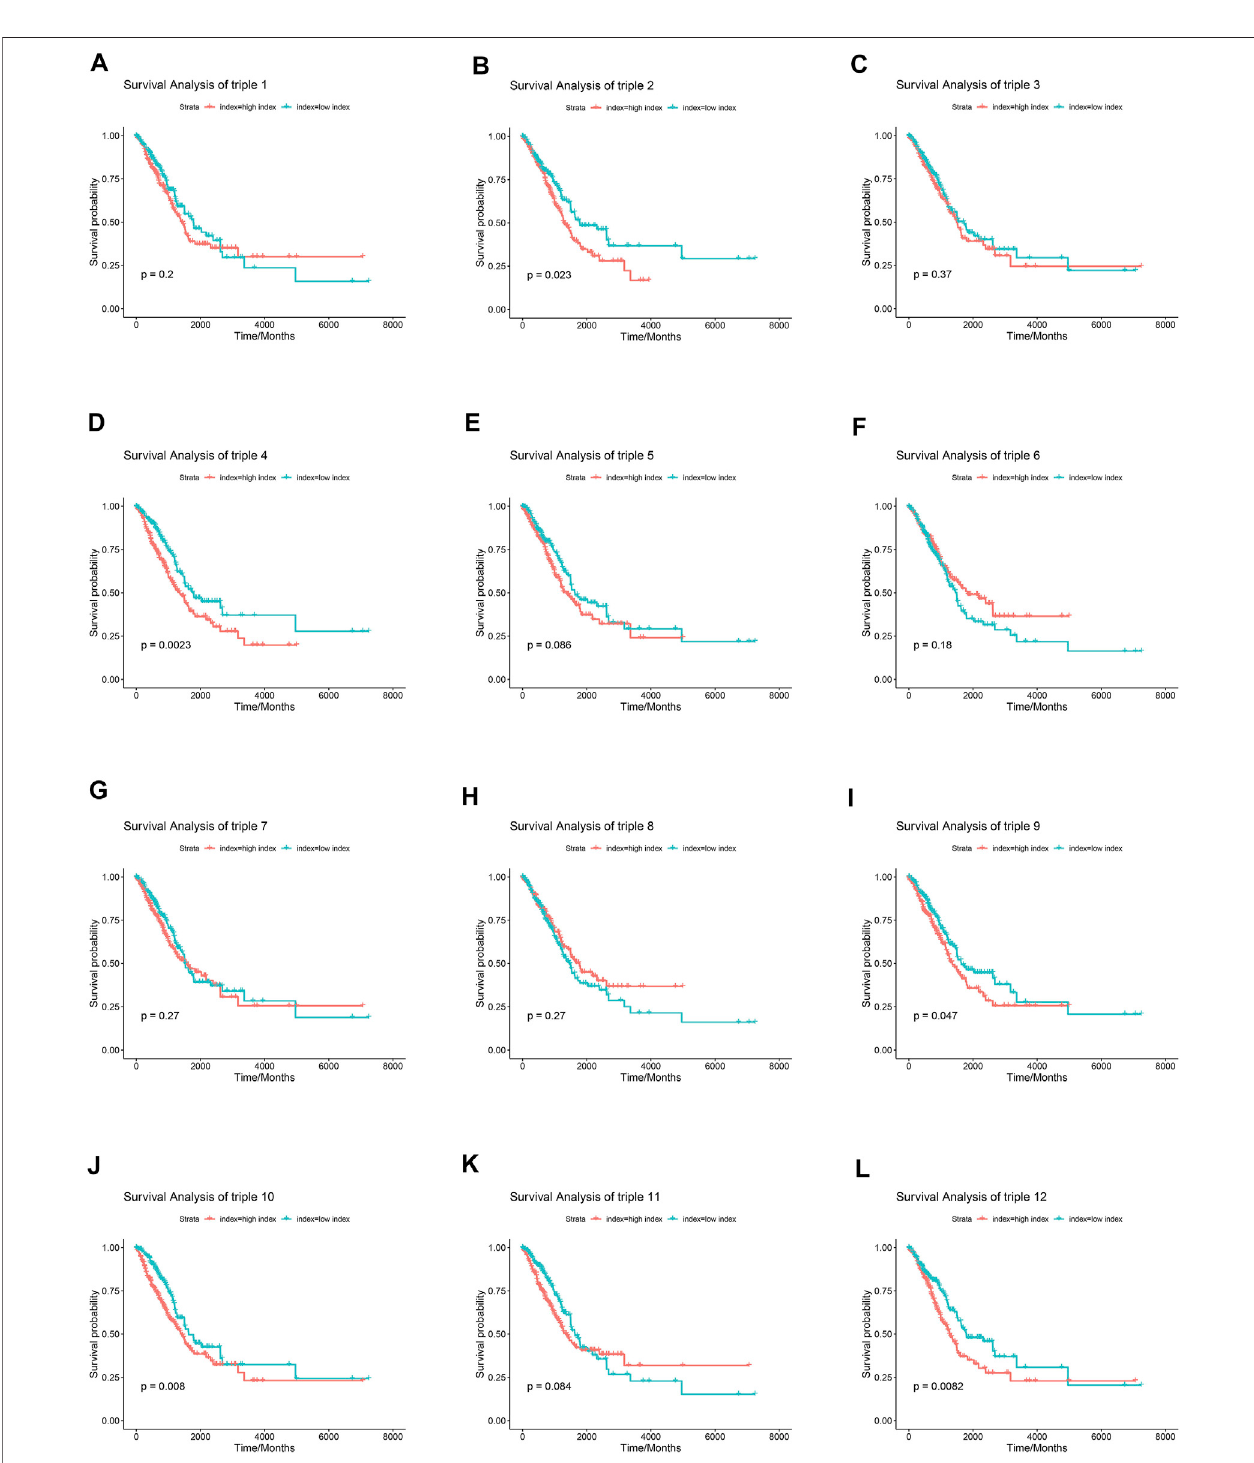
FIGURE 8 | Association between core lncRNA-miRNA-mRNA regulatory sub-networks and Overall survival (OS) in patients with NSCLC in the TCGA. Red lines indicate the higher expression group. Greened lines indicate lower expression group. The horizontal axis demonstrates the overall survival time in years, and the vertical axis indicates the survival